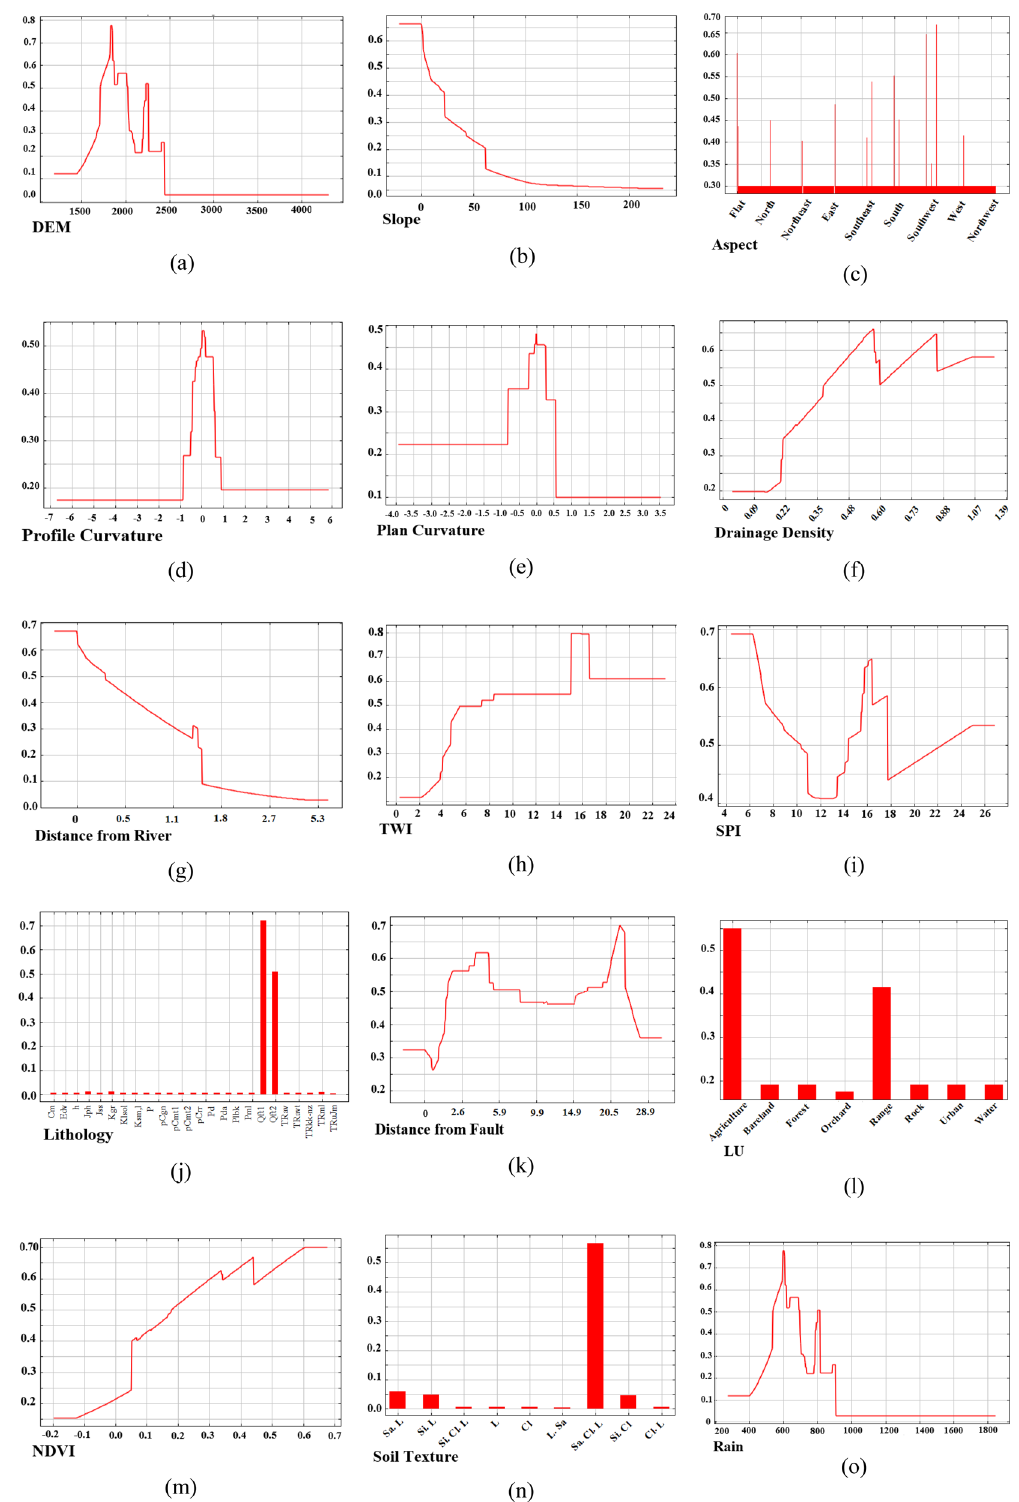
Figure 6. Marginal response curves for the quantitative conditioning factors (y-axis: predicted probability of GWR potential related to each conditioning factors). (a) Elevation; (b ) slope degree; (c) slope aspect; (d) profile curvature, (e) plan curvature, (f) drainage density; (g) distance from river; (h) TWI; (i) SPI; (j) lithology; (k) distance from fault; (l ) LU; (m) NDVI; (n) Soil texture and rain (o) (prepared in maxent 3.3.3 k